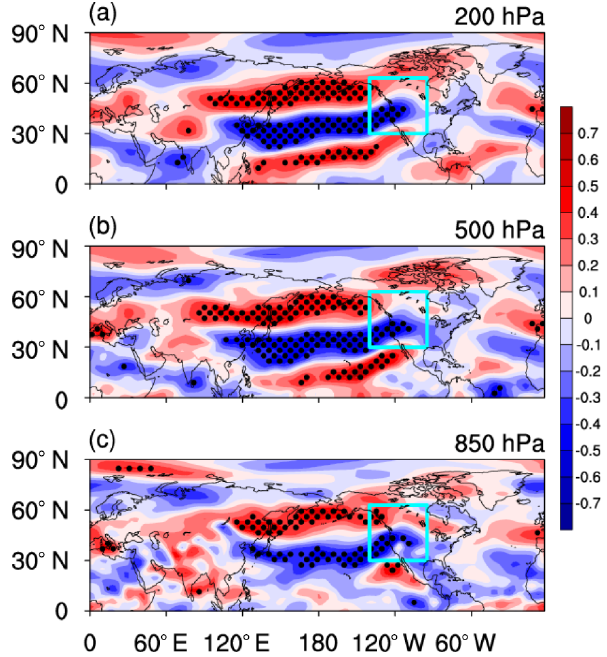
Figure 3. Correlation coefficients between March ASO index and April zonal wind variations (ms − 1 ; from NCEP-2) from 1984 to 2016 at 200hPa (a) , 500hPa (b) and 850hPa (c) . Dots denote sig- nificance at the 95% confidence level, according to Student’s t test. Blue square is the area shown in Fig. 1. Before performing the anal- ysis, the seasonal cycle and linear trend were removed from the original datasets.